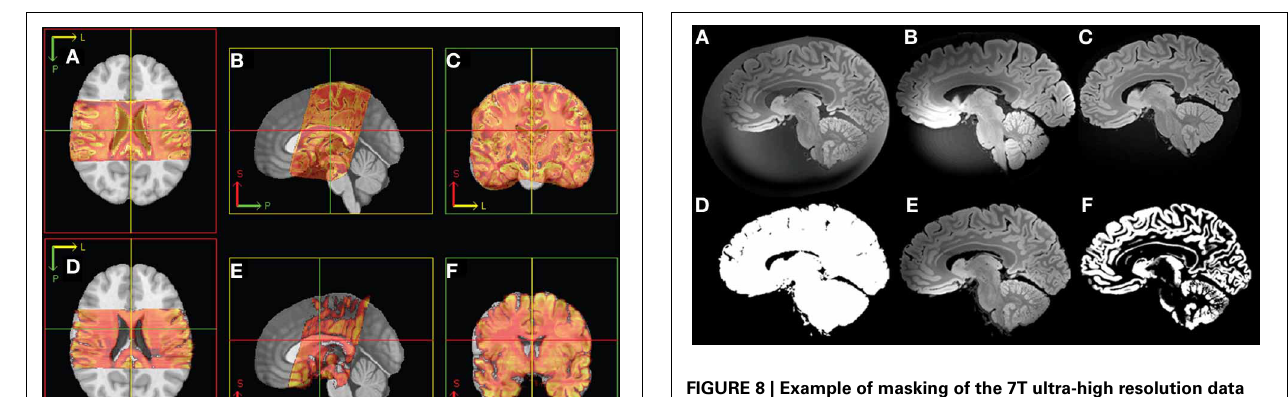
FIGURE 8 | Example of masking of the 7T ultra-high resolution data set. (A) ultra-high resolution data set; (B) MPRAGE at 7T; (C) MPRAGE at 3T; (D) Mask; (E) masked ultra-high resolution data; (F) GM after Segmentation using VBM8.